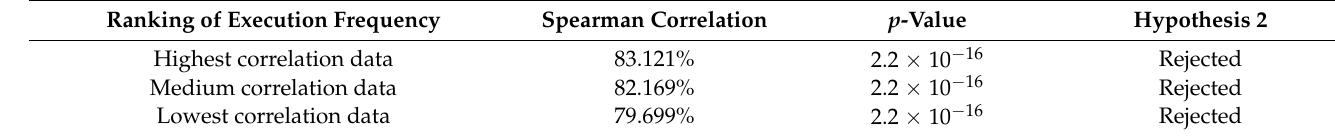
Table 8. The correlation between the function ranking of execution frequency after actual usage.